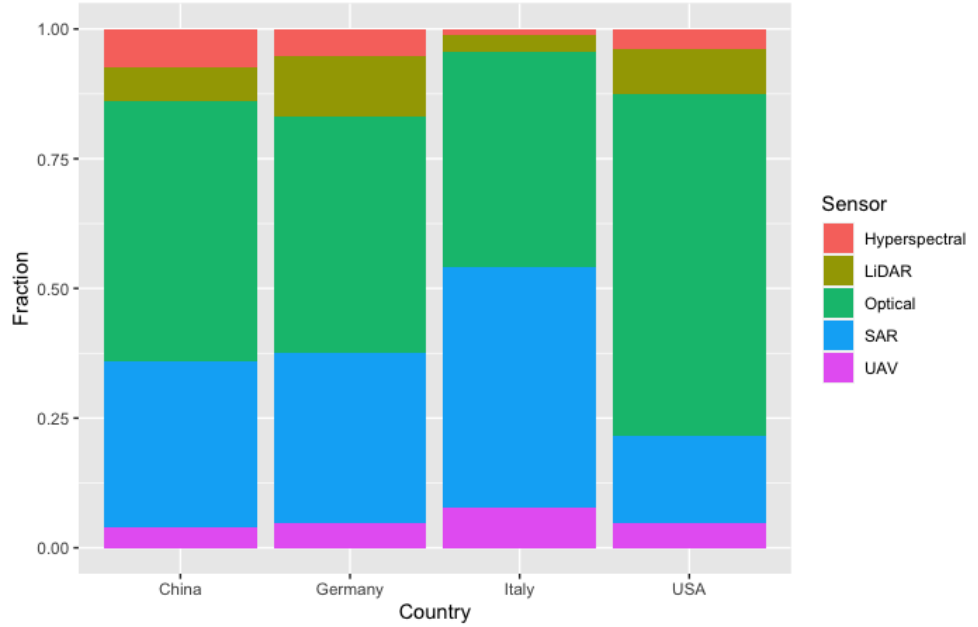
Figure 7. Fractions of articles published in Remote Sensing using a specific sensor by selected